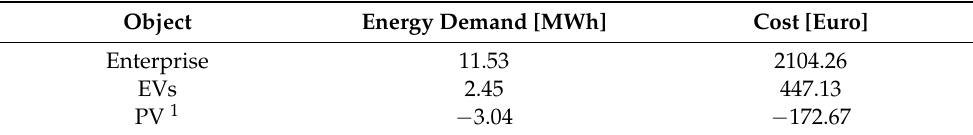
Figure 17. The control algorithm for model II. Table 4. Summary of energy consumption for the company and the vehicle fleet for model